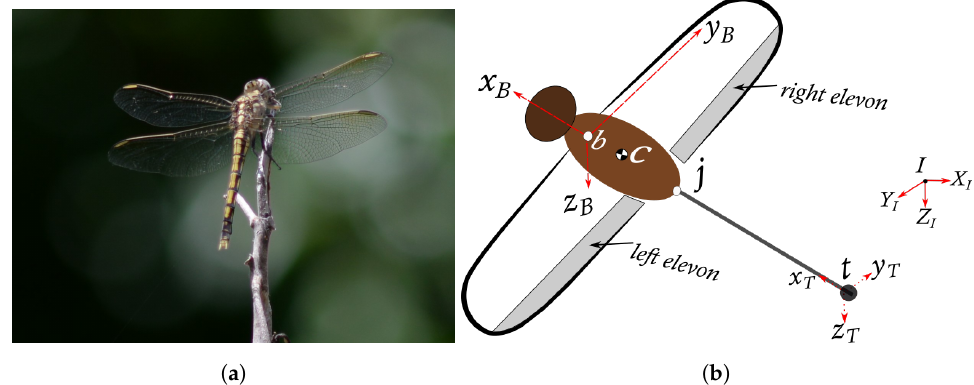
Figure 2. Description of the DISWA: ( a ) Photograph of an Australian emerald dragonfly, Hemicordulia australiae . ( b ) Reference points and coordinate systems of the dragonfly-inspired straight- wing aircraft